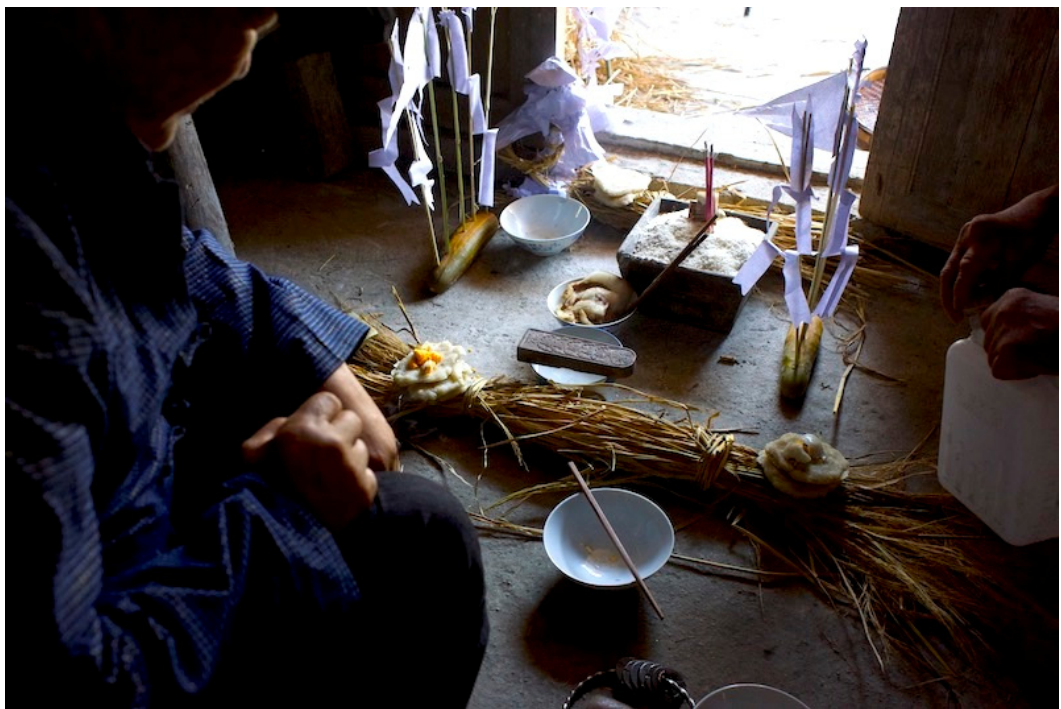
Figure 5. Badai Shi Changwu at the right altar in front of the main door to the family’s home. (Photo: Thomas Riccio).